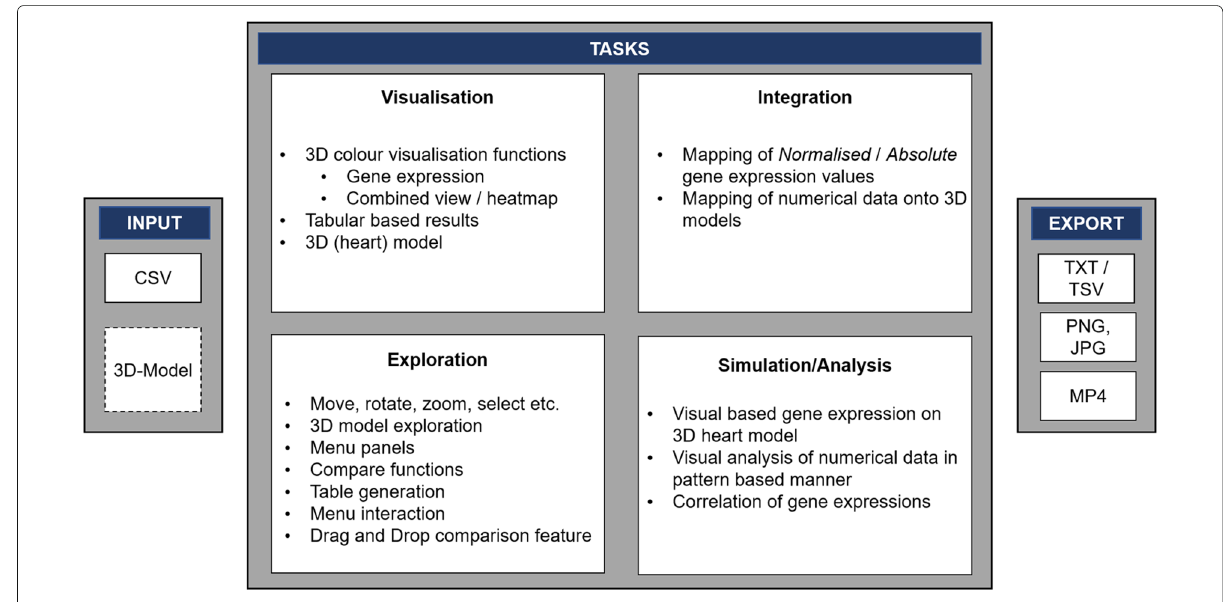
Fig. 5 Functionalities of VR-Cardiomics